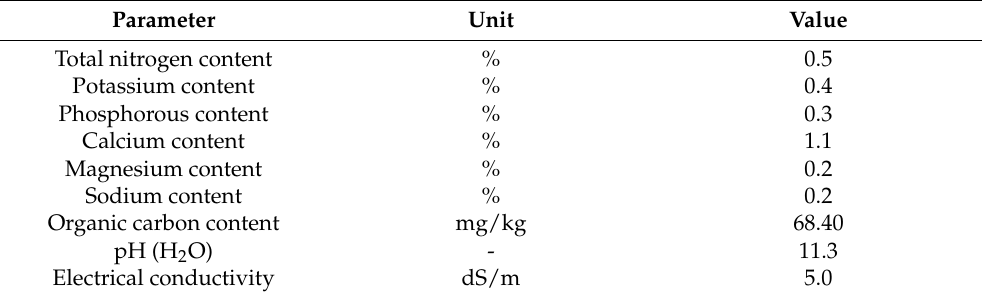
Table 4. Chemical and physical properties of the biochar used in the study. Parameter Unit Value Total nitrogen content